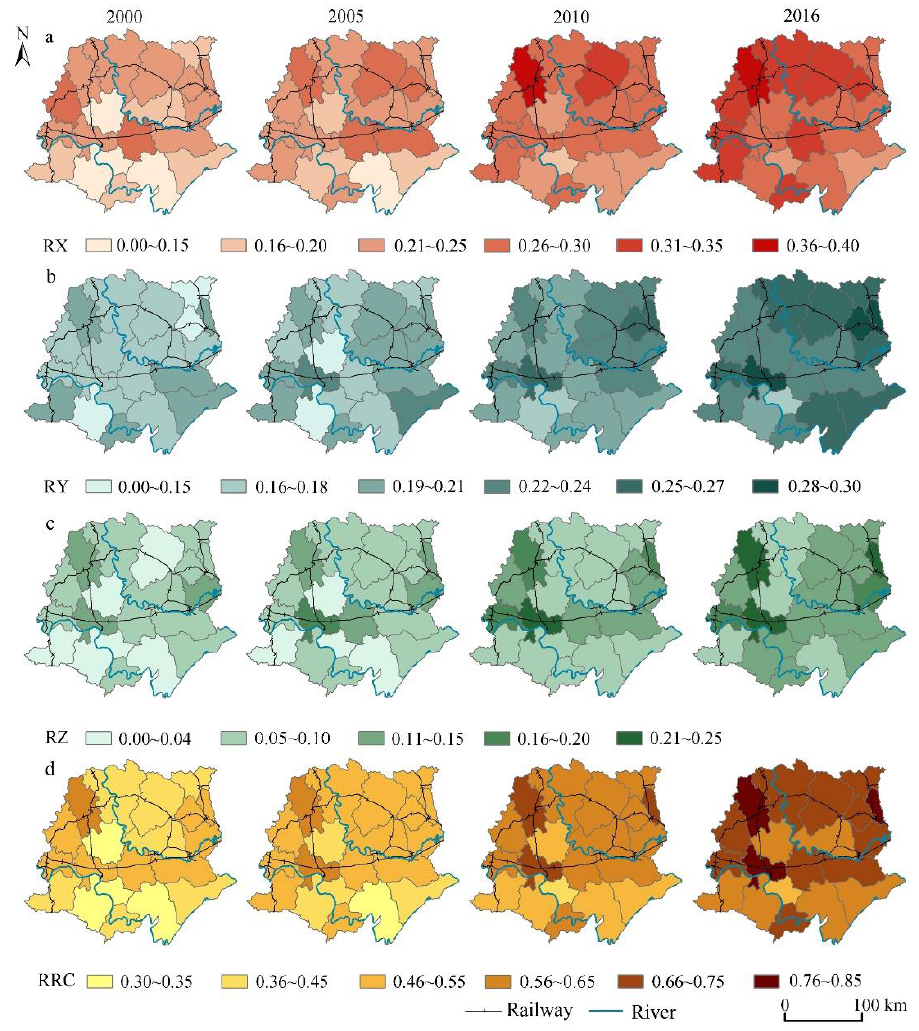
Figure 3. Spatial patterns and changes during rural reconstruction of the Plain, 2000 – 2016. ( a ) eco- nomic restructuring, ( b ) social restructuring, ( c ) spatial restructuring, ( d ) rural restructuring.